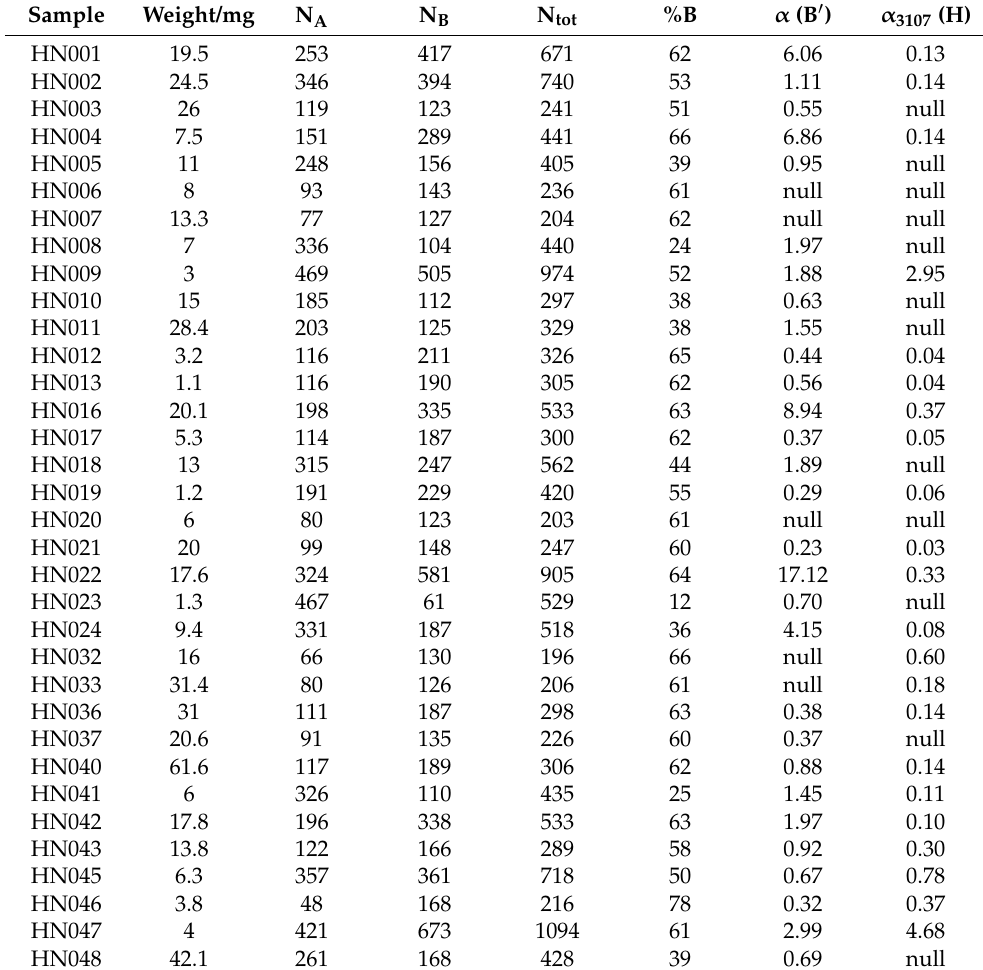
Table A1. Evaluation of nitrogen and hydrogen defects in type IaAB Hunan diamonds by